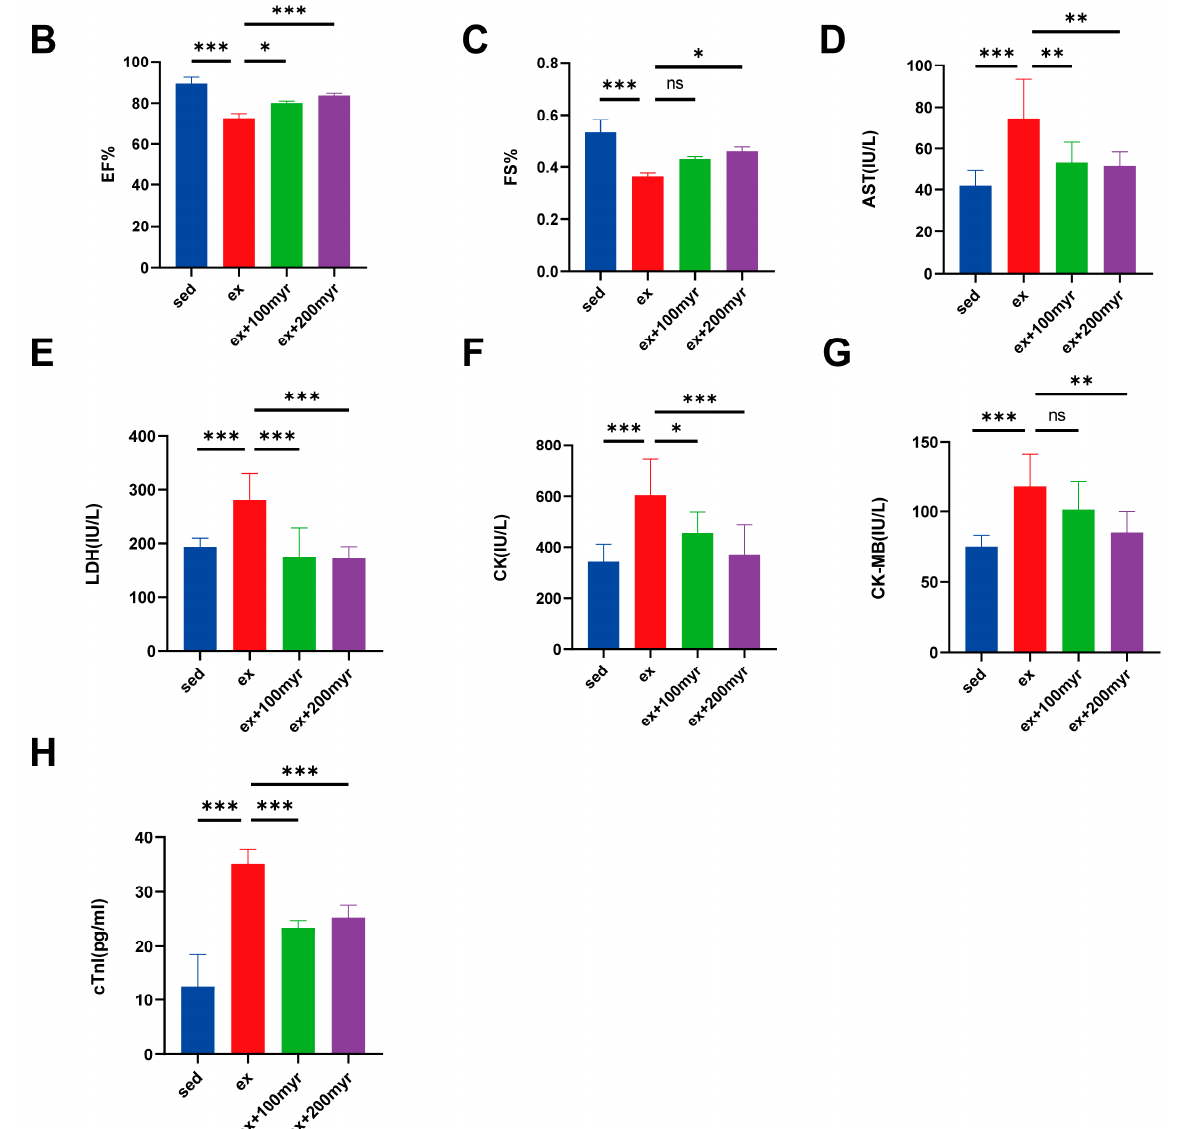
Figure 1. Effects of myricetin on cardiac function and serum marker levels in HIE. ( A ) Representative M-mode echocardiograms; ( B ) ejection fraction (EF%) values; ( C ) left-ventricular short-axis shortening (FS%) values; ( D ) AST; ( E ) LDH; ( F ) CK; ( G ) CK-MB; and ( H ) mouse serum troponin I (cTnI). The data are presented as mean ± SD. * p < 0.05, ** p < 0.01, *** p < 0.001, and ns represents no statistical difference.